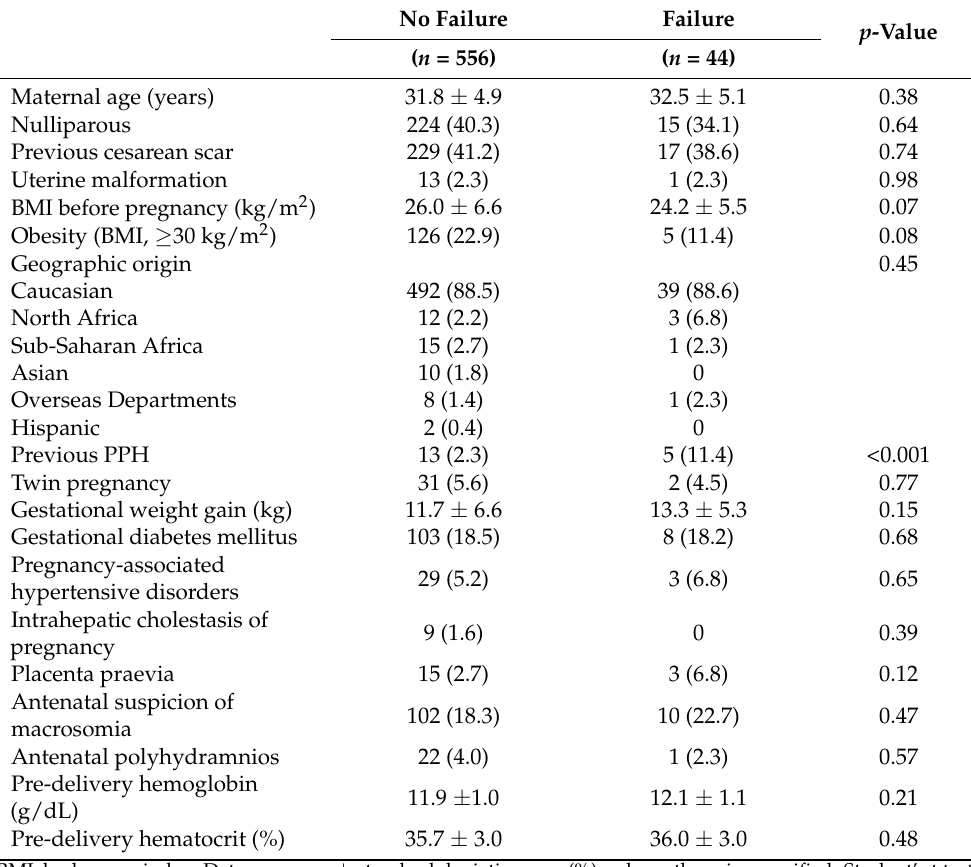
Table 1. Maternal and pregnancy characteristics according to the carbetocin